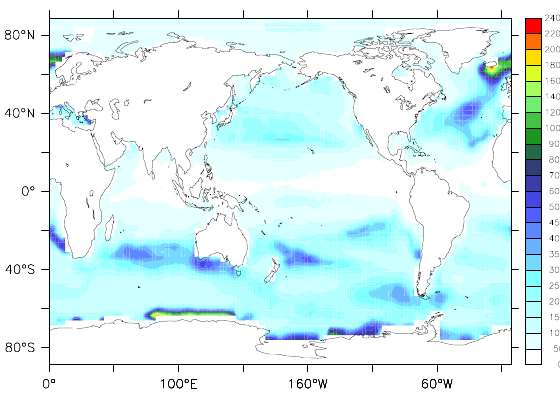
Fig. 10. The maximum of the ensemble mean of the monthly mean mixed-layer depth in SPEEDO in m .